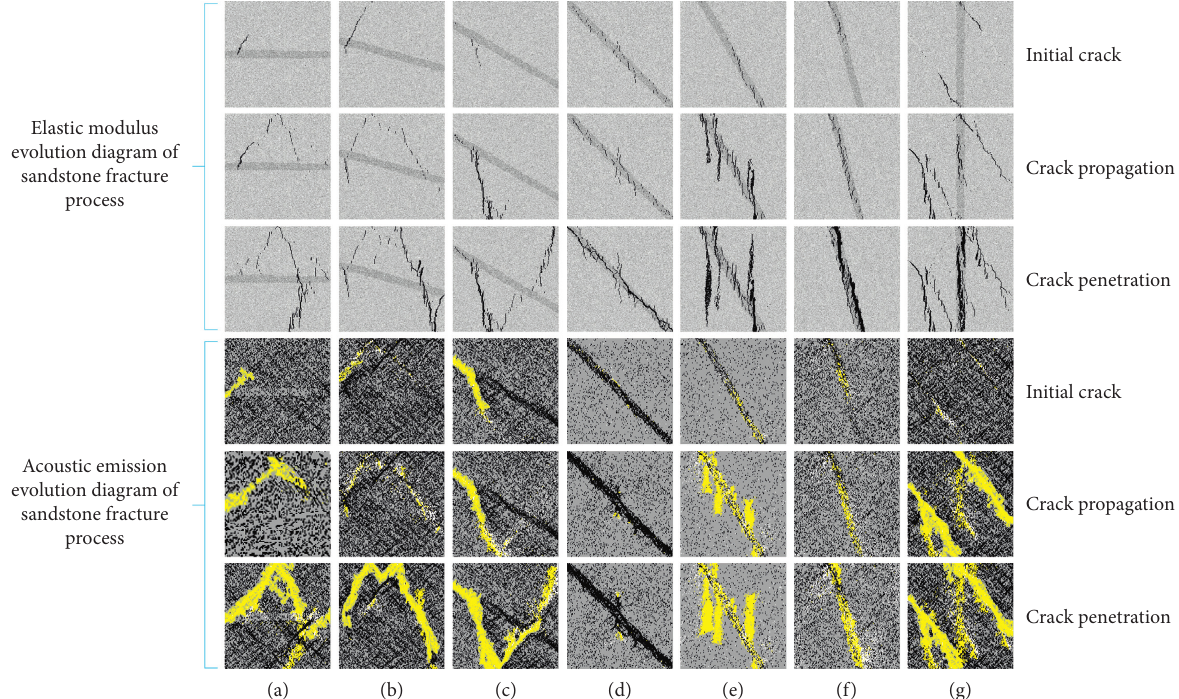
Figure 10: Crack propagation characteristics and fracture process evolution diagram of jointed sandstone with different dip